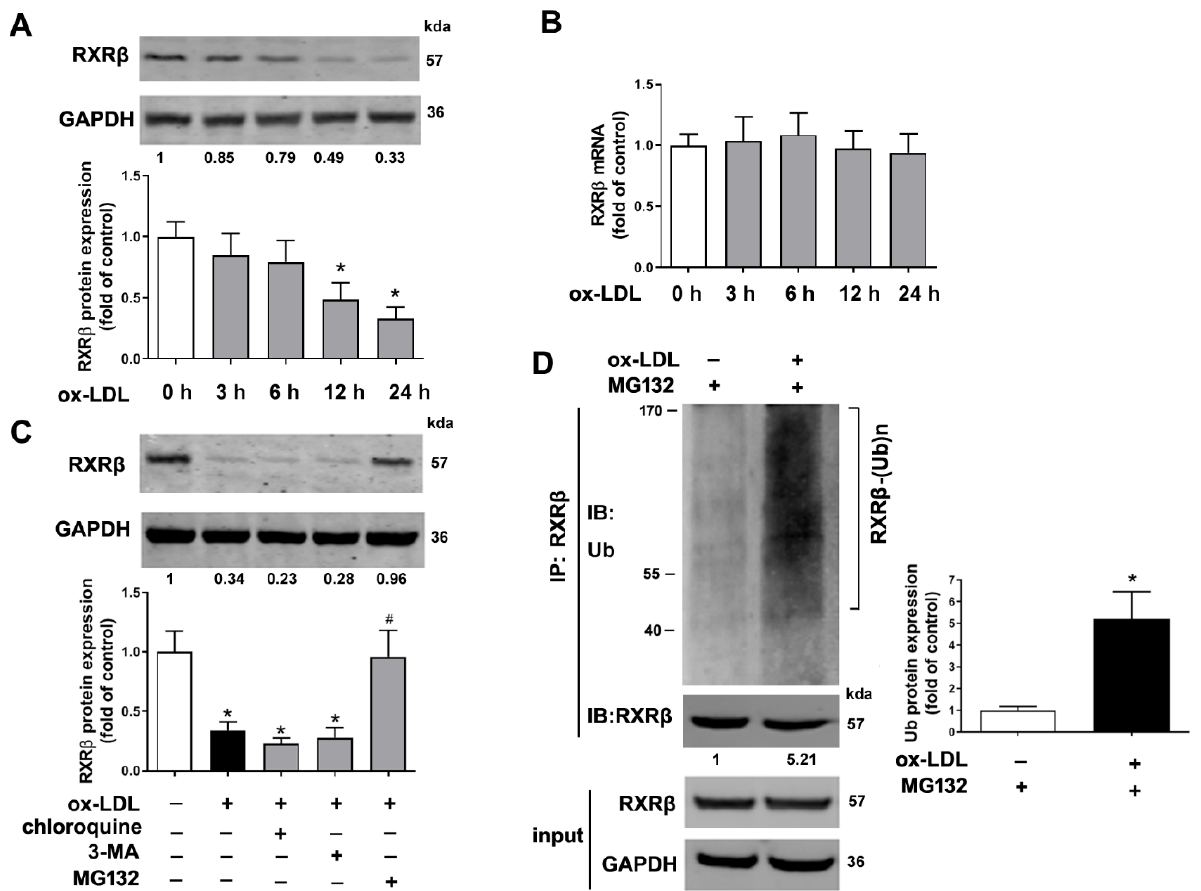
Figure 1. RXR β is ubiquitinated in ox-LDL-induced HAECs. ( A , B ) protein and mRNA expression of RXR β in HAECs which were incubated with 100 μ g/mL ox-LDL at various times. ( C ) HAECs pretreated with 3-methyladenine (3-MA, 5 mM), chloroquine (25 μ M), or MG132 (20 μ M) for 1 h were incubated in the presence and absence of ox-LDL (100 μ g/mL) for 24 h. Then, protein expression of RXR β was determined. ( D ) The immunoprecipitation results showed the ubiquitination of RXR β in HAECs under ox-LDL (100 μ g/mL) for 24 h in the presence of MG132 (20 μ M). Results are presented as the mean ± SD. n = 6. * p < 0.05 vs. control group, # p < 0.05 vs. ox-LDL alone group.